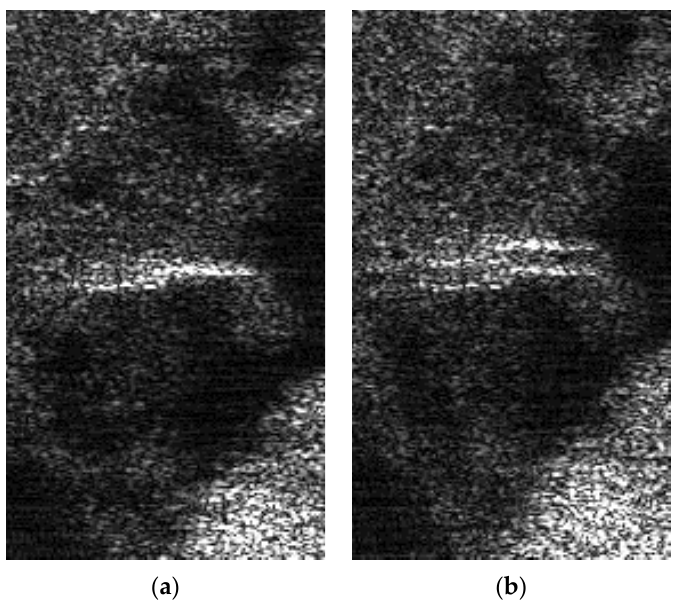
Figure 10. Demonstration of azimuth resolution degradation. ( a ) SAR image before DCC. ( b ) SAR image after